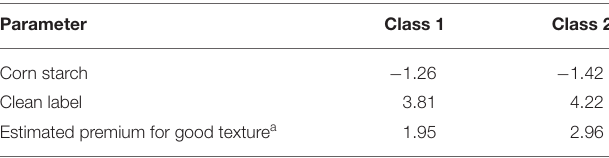
TABLE 6 | Latent class logit willingness to pay estimates for significant